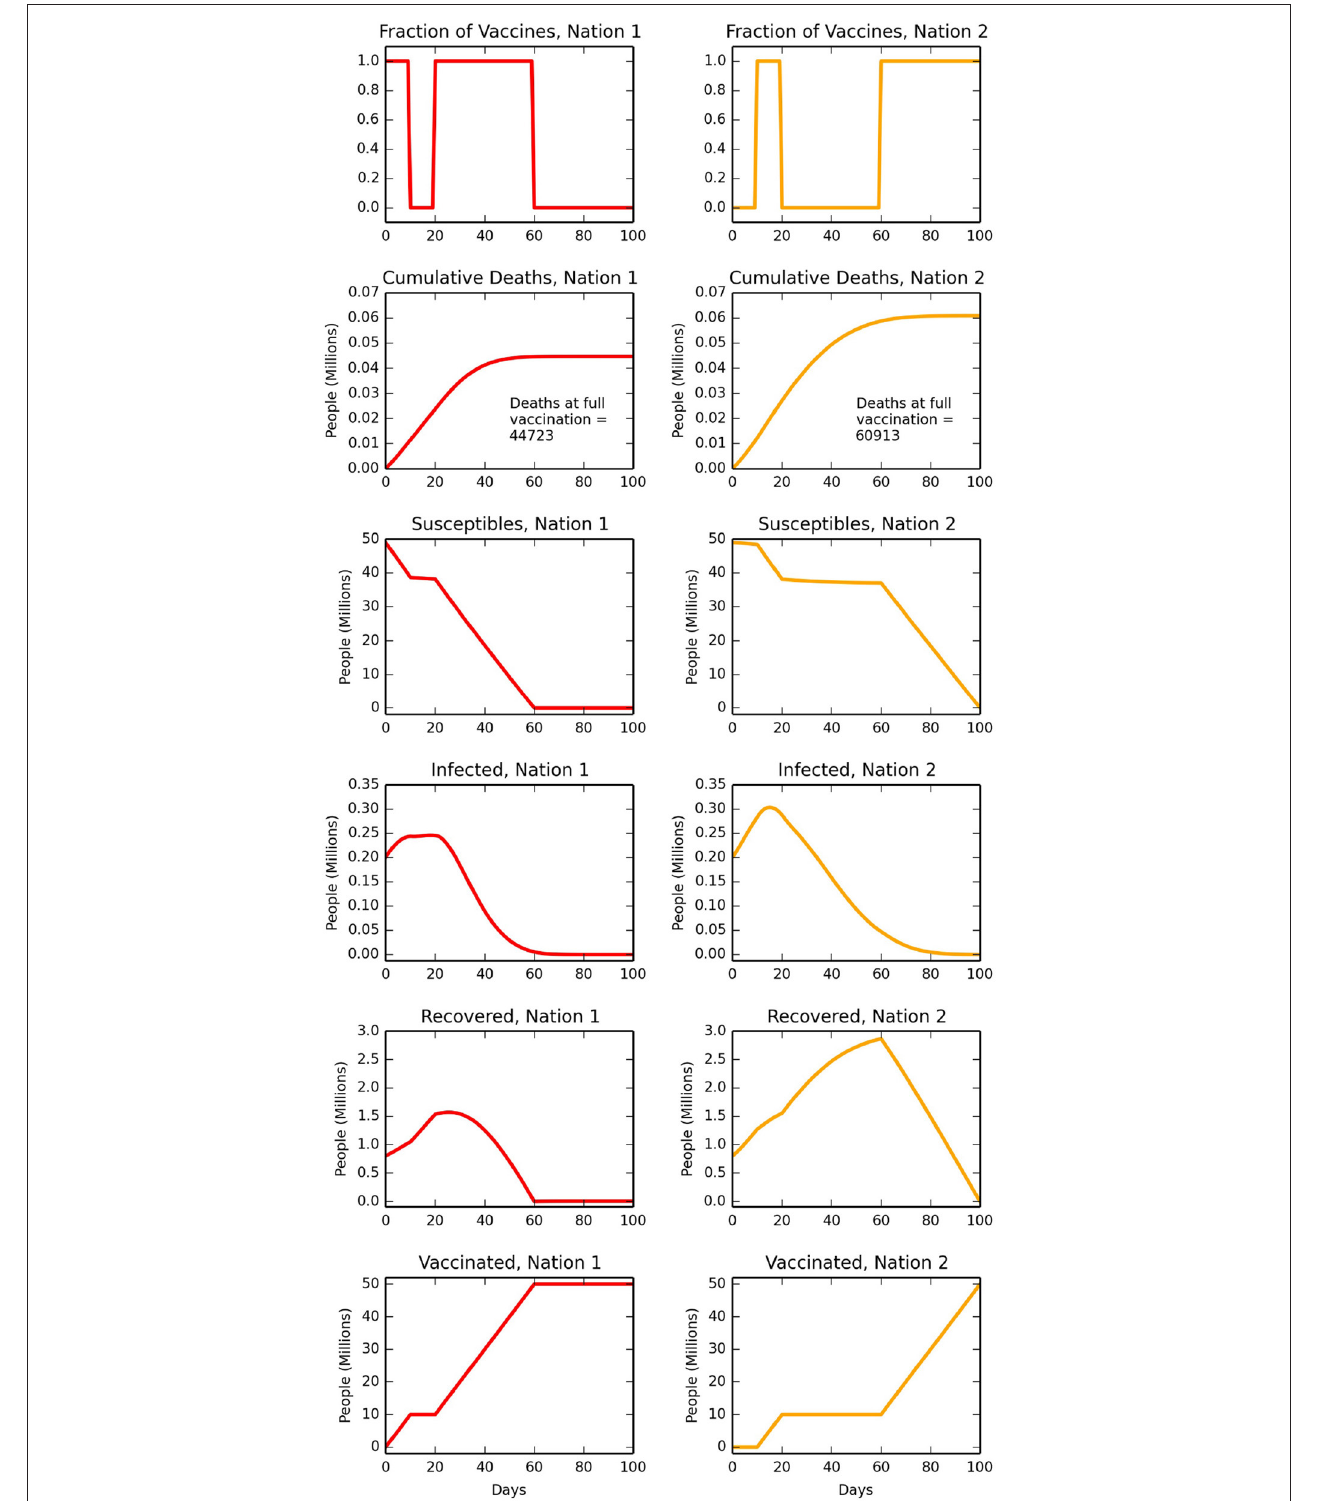
FIGURE 1 | Calculations with parameters and initial conditions as given in Table 1 , and including for extensive travel with f 1 = f 2 = 0.2. The left-hand column are time-evolving projections for nation one and that has developed the vaccine, and right-hand column are for nation two. After 20% of the population of nation